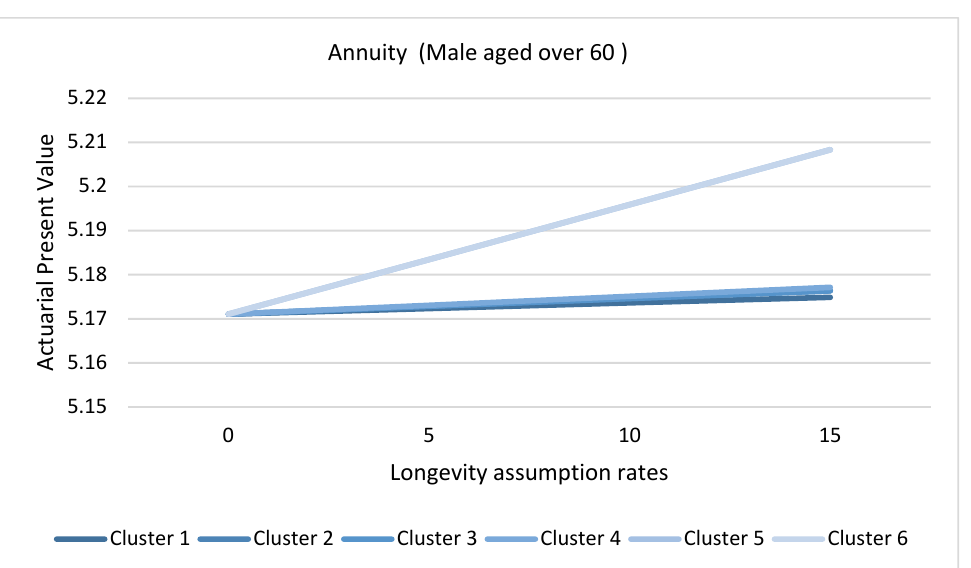
Figure 21. APV for females aged over 60 clusters against longevity assumption rates.